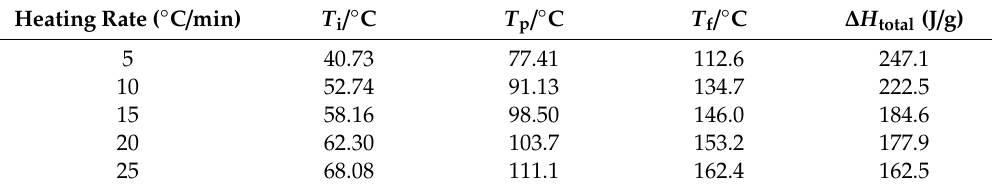
Figure 2. Di ff erential scanning calorimetry (DSC) curves of the phenolic amine / epoxy resin system. Figure 2. Differential scanning calorimetry (DSC) curves of the phenolic amine/epoxy resin system. Table 2. Data from the analysis of DSC measurements at di ff erent heating Table 2. Data from the analysis of DSC measurements at different heating rates.